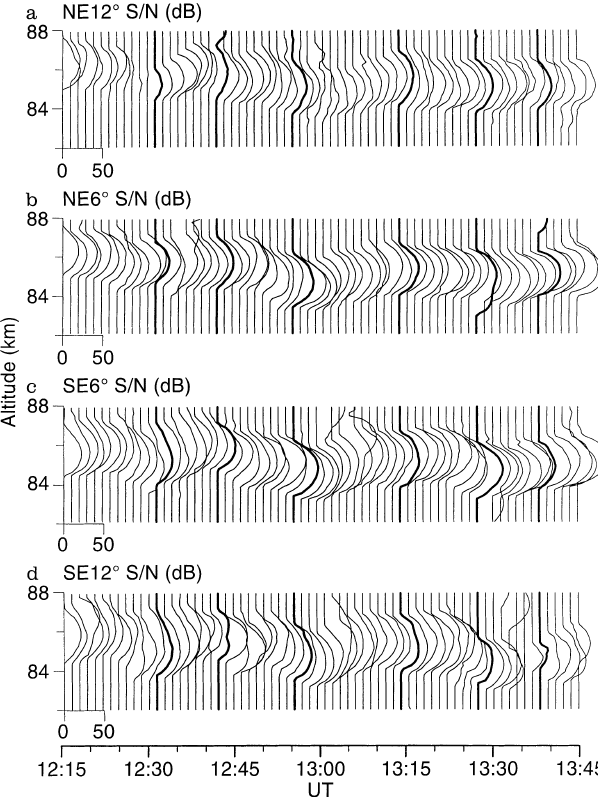
Fig. 2a–d. Altitude profiles of S/N for a NE12 (cid:14) , b NE6 (cid:14) , c SE6 (cid:14) , d SE12 (cid:14) on 17 June 1993. The bold profiles correspond to those in